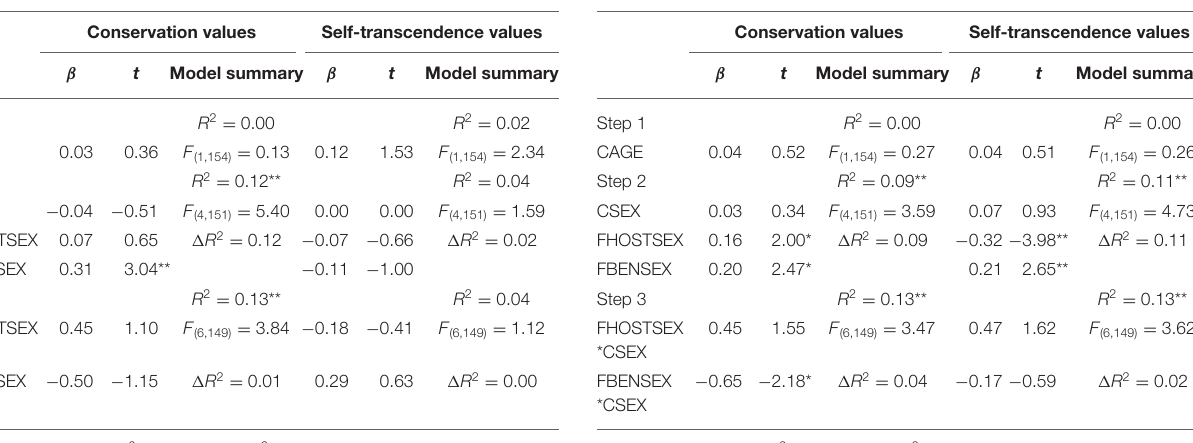
TABLE 2 | Hierarchical multiple regression models with mothers’ variables. TABLE 3 | Hierarchical multiple regression models with fathers’